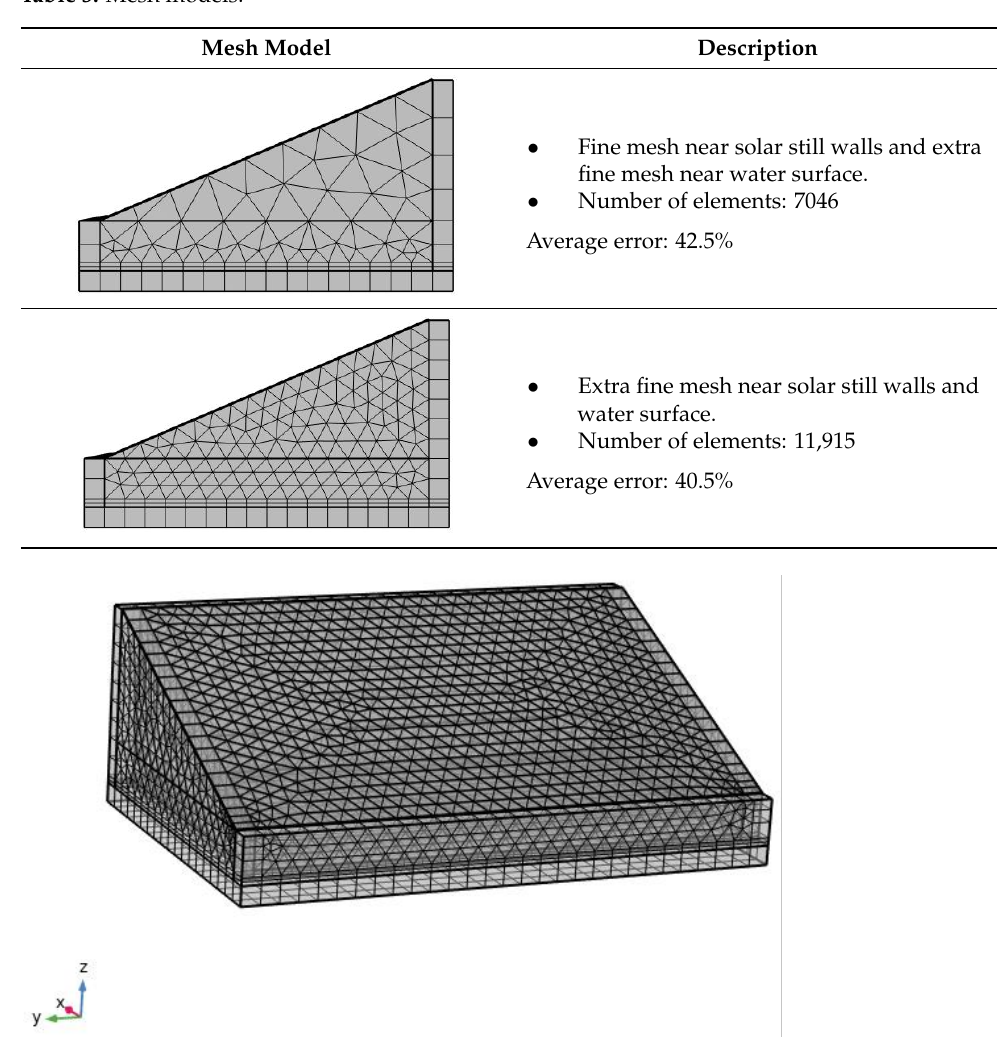
Figure 3. Mesh model of the solar still .